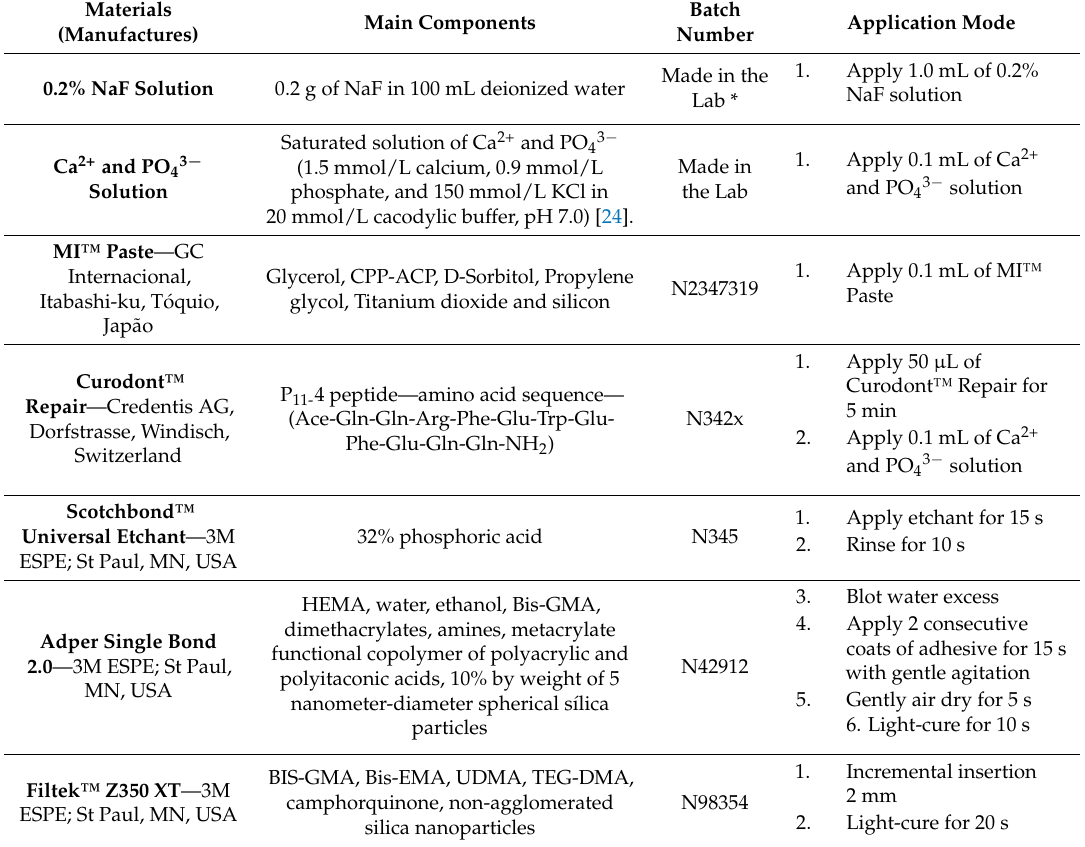
Materials, manufactures, components, batch numbers and application mode of tested